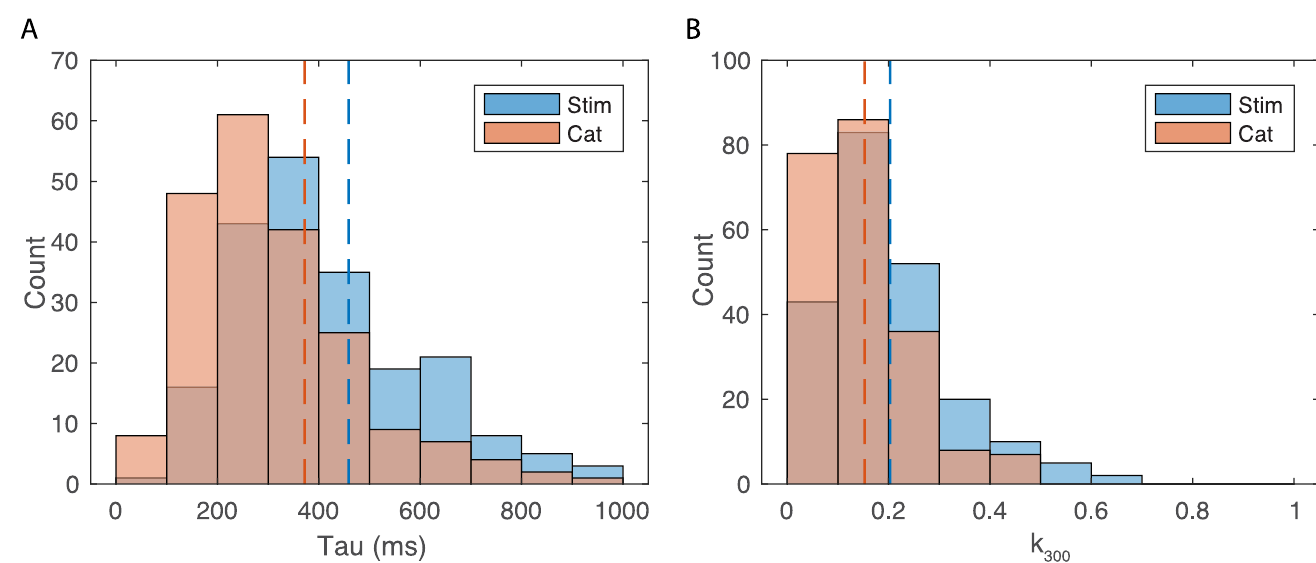
Fig 7. Time constants (tau) for cumulative information and relative cumulative information estimated at 300 ms (K 300 ). For a large fraction of neurons (214/ 337 neurons), cumulative information for stimuli and call-type categories were well fitted with exponential curves. The time constants of the exponential fits were used as a time integration estimate for cumulative information (A). The exponential fits were also used to estimate the cumulative information obtained at 300 ms relative to the maximum achievable information (log 2 (n stim ) or log 2 (n cat )), k 300 . k 300 is a number between 0 and 1 (B). A . Histogram of the distributions of time constants of the exponential fit for stimuli and call categories. Dashed lines indicate the mean of each distribution (Stim = 459 ms; Cat = 372 ms). B . Histogram of the two distributions of k 300 . Dashed lines indicate the mean of each distribution (Stim = 0.2; Cat = 0.15).